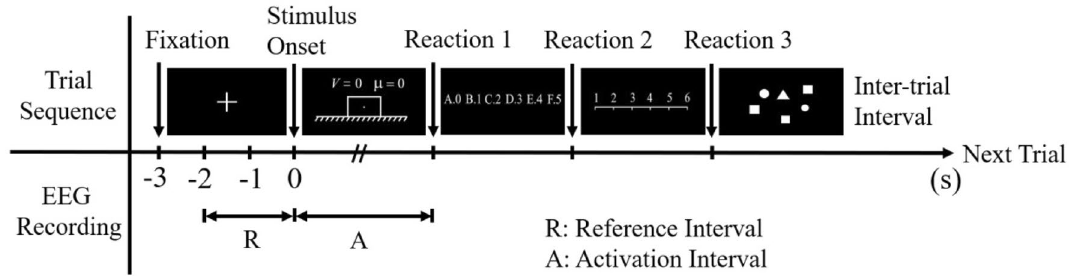
Figure 4. Schematic of a single trial. The time period from the onset of a scientific problem to reaction 1 serves as the activation interval, the time period from 1 to 3 s after the onset of the fixation cross serves as the reference